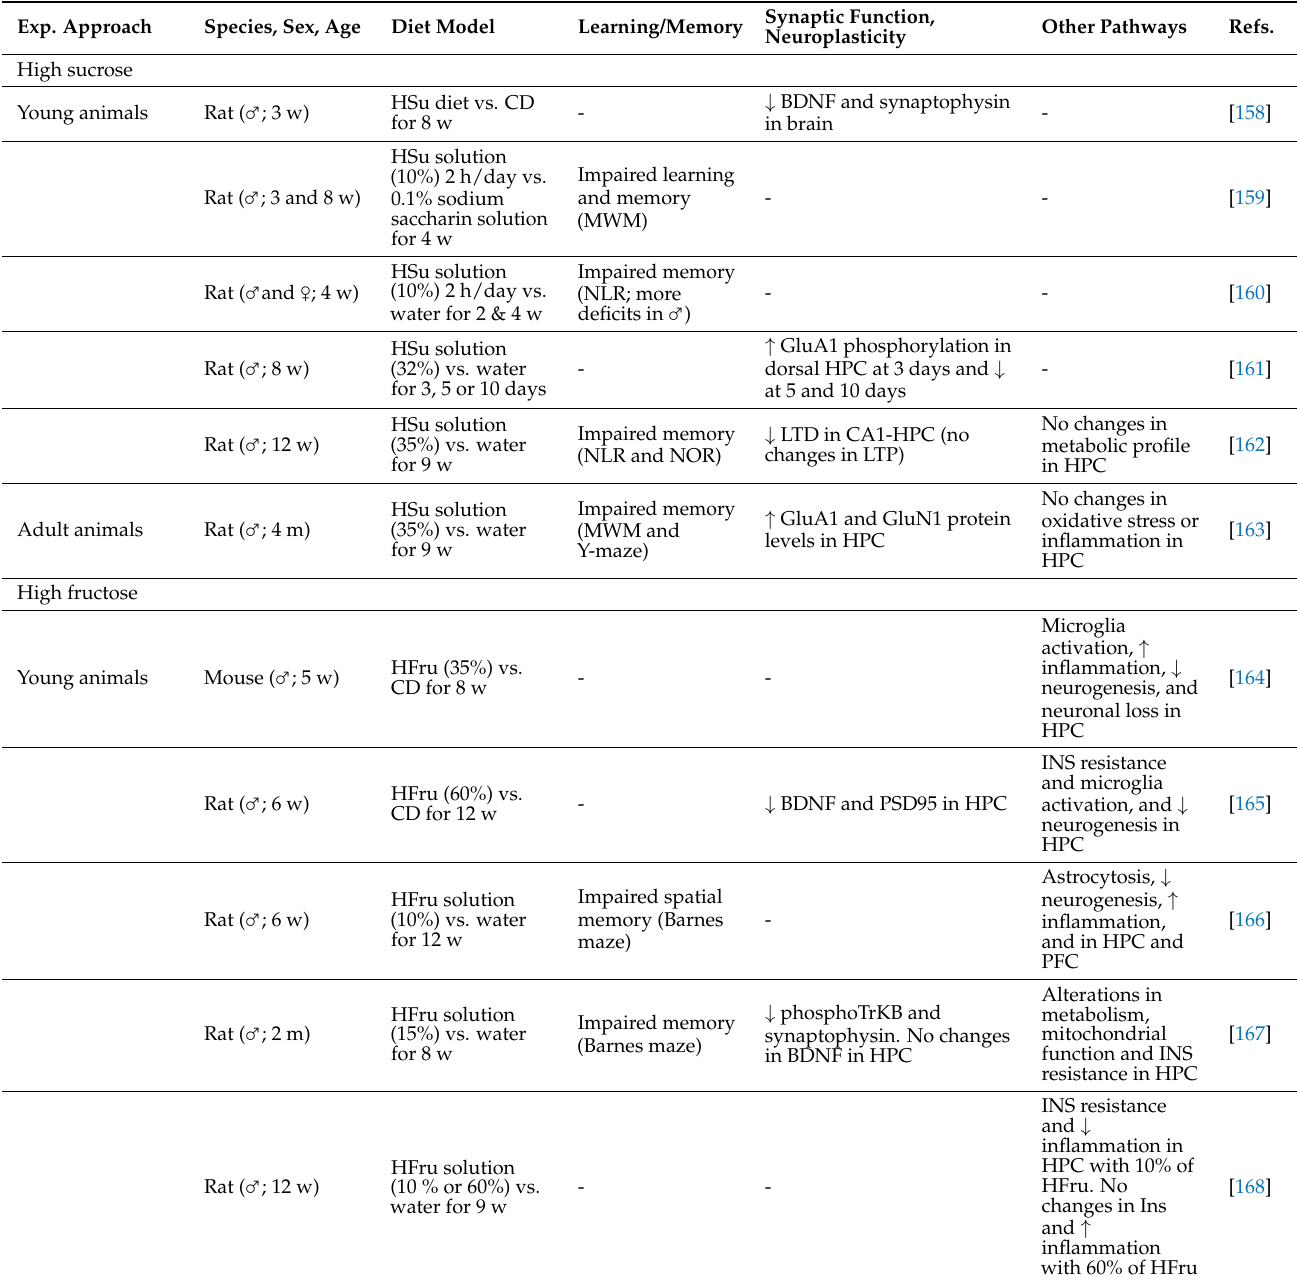
Table 3. HSD effects on synaptic function and cognition in